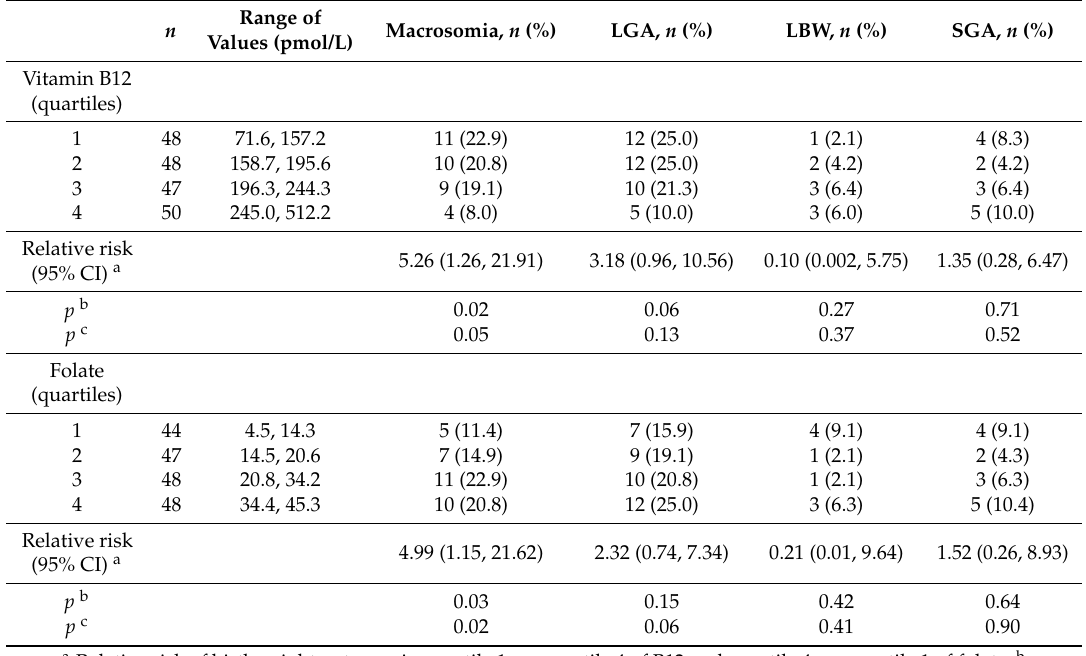
Table 4. Relationship between maternal B12 on birth outcome measures in no-GDM